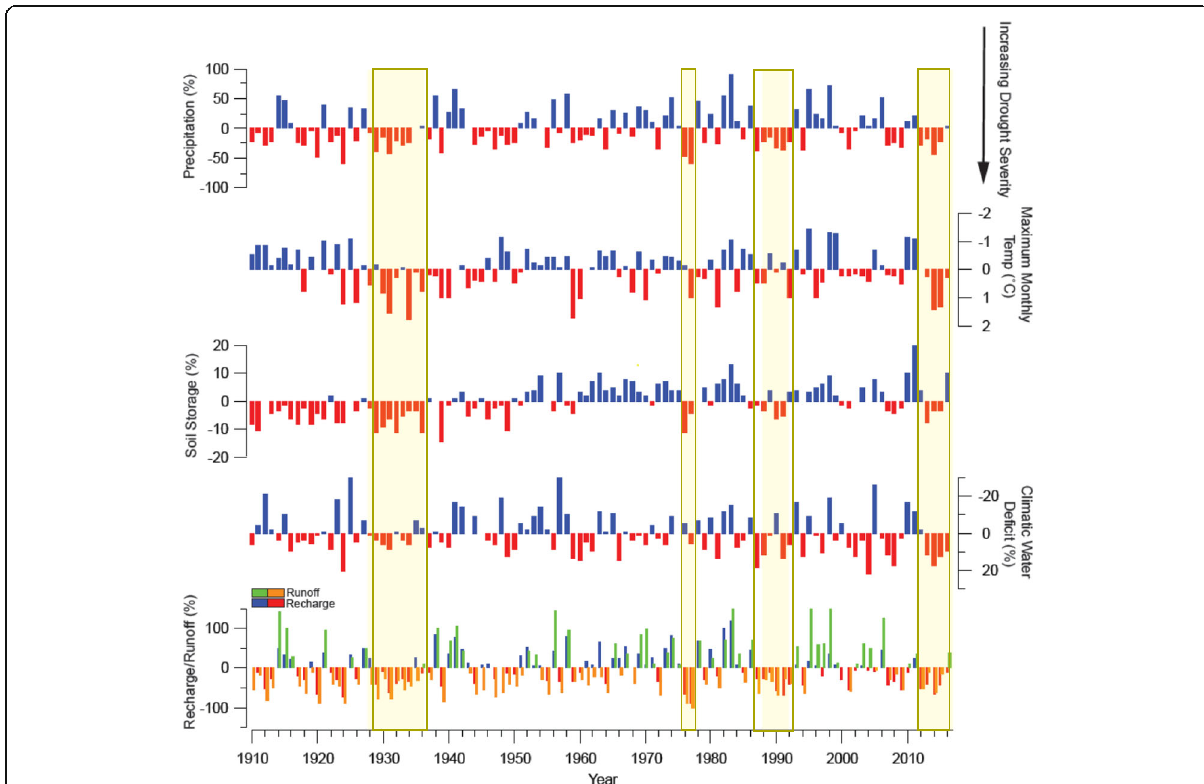
Fig. 5 Historical conditions in the Russian River basin represented as anomaly from the long-term mean for water years 1910 – 2016 for annual precipitation, average air temperature, soil moisture, climatic water deficit, and recharge and runoff. Drought periods are identified by yellow vertical